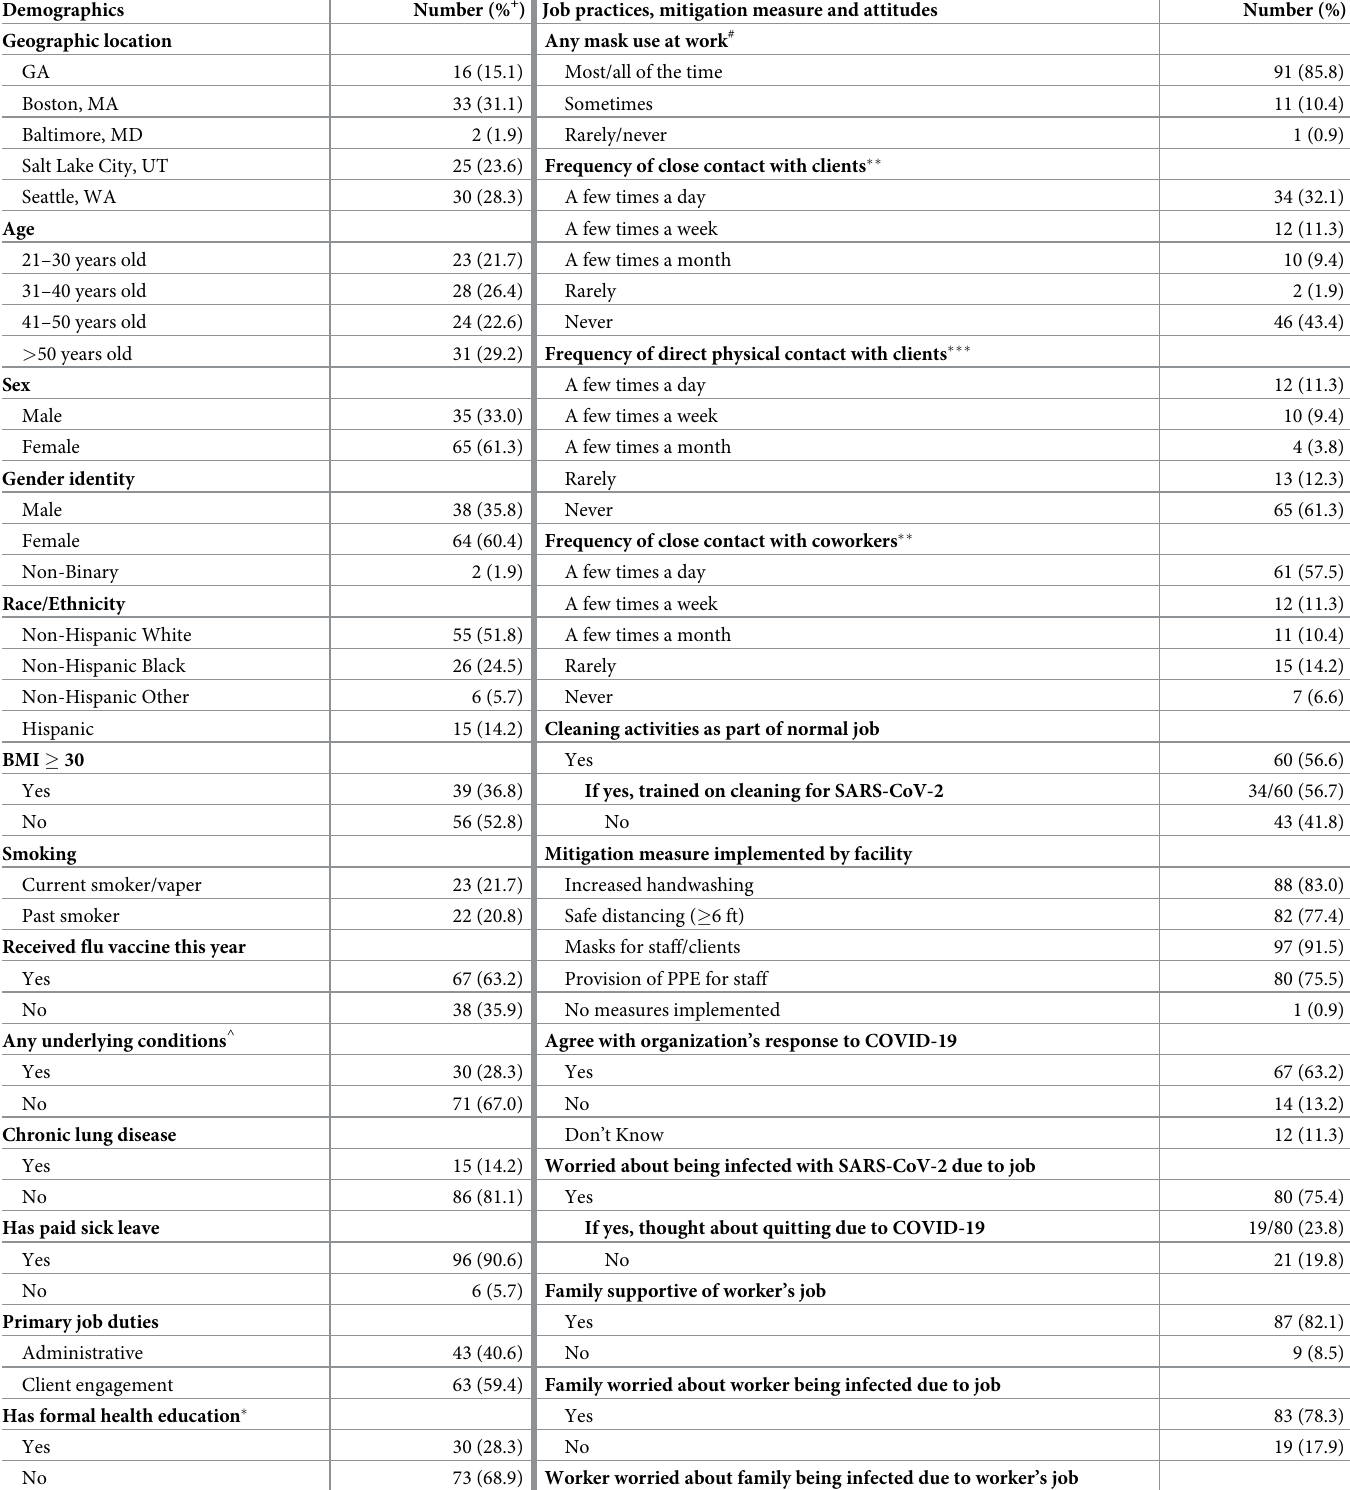
Table 1. Demographics, job practices and COVID-19 mitigation measures of homeless shelter workers (N = 106).